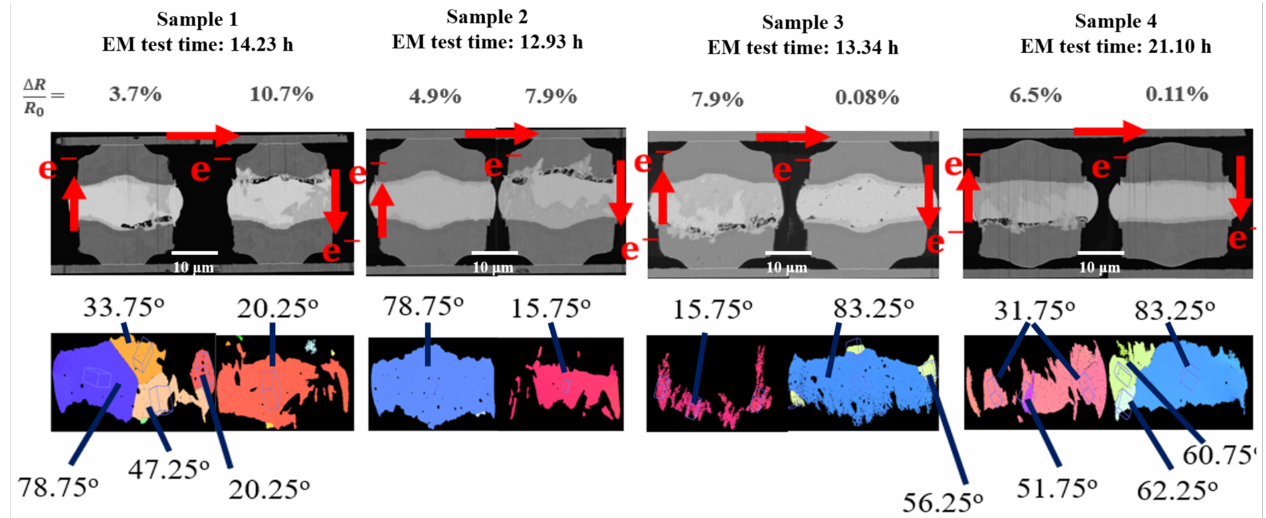
Figure 6. Cross-sectional FIB and EBSD images of the solder joints with different α -angle stressed at a high current density. The electrical flows are denoted by the red